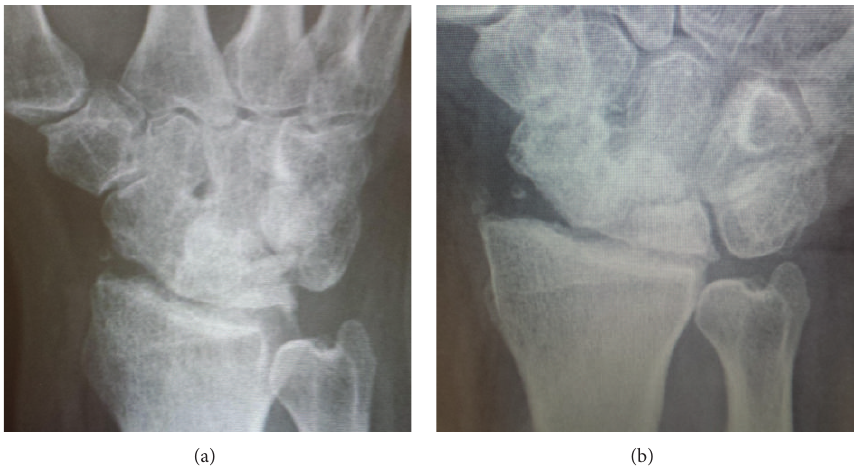
Figure 8: Wrist radiographs showing maintained joint space at 2